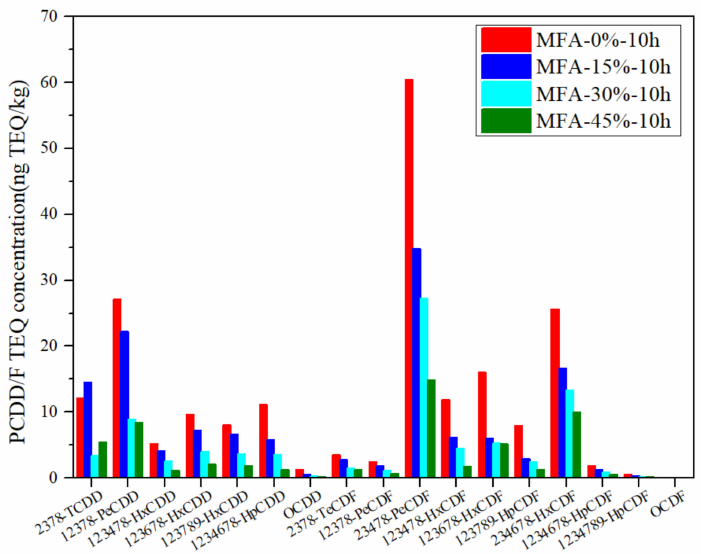
Figure 5. Concentrations of 17 2,3,7,8-substitued PCDD/Fs after MC treatment for 10 h.